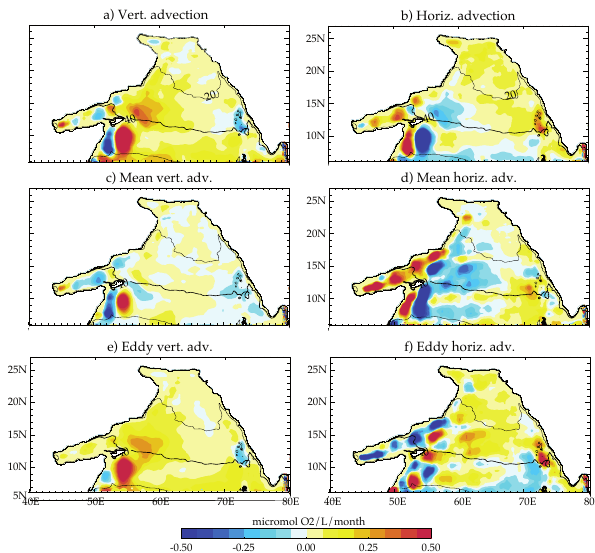
Fig. 10. Simulated annual trends of oxygen between the 200 and 1500 m: (a) vertical advection, (b) horizontal advection, (c) mean vertical advection, (d) mean horizontal advection, (e) eddy-driven vertical advection and (f) eddy-driven horizontal advection. Units are in µmolL − 1 month − 1 . Contours delimits the 20, 40 and 60µmolL − 1 oxygen concentration on average between 200 and 30